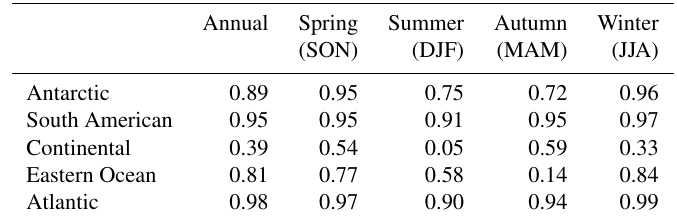
Table 5. Correlation coefficient ( R 2 ) of regional average concentrations with averages of all measurements at Cape Point. Values are based on monthly averages ( N = 30). Antarctic, Atlantic, and South American air masses exhibit a high correlation with the overall mean concen- trations observed at Cape Point.